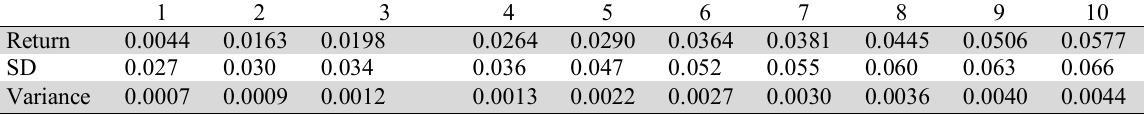
Fig. 1. The efficient frontier of portfolio optimization using genetic algorithms Comparison of the efficient frontier derived from optimized portfolio formation using genetic algo- rithms, with risk-return curve shows the ability of genetic algorithms in optimization of the portfolio. Therefore the second hypothesis is rejected. The results of risk and return using genetic